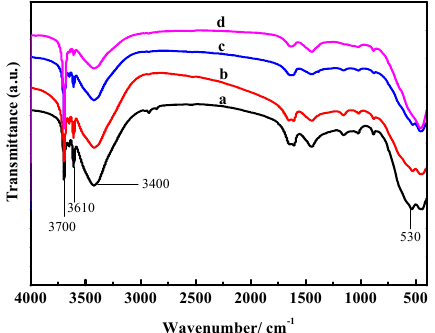
Figure 15. FT-IR spectra of the inner cores of the MOC samples after different dry–wet cycles: (a) without dry–wet cycles; (b) one time; (c) two times; (d) three times.